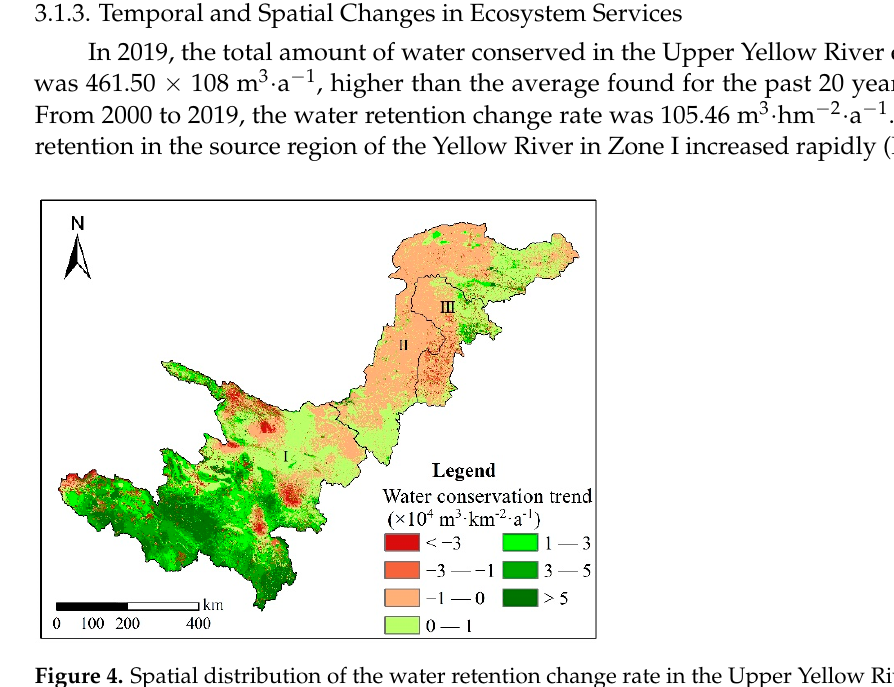
Figure 5. Spatial distributions of the soil erosion modulus ( a ) and soil conservation ( b ) change rates in the Upper Yellow River region. Figure 6. Spatial distributions of the wind erosion modulus ( a ) and windbreak and sand fixation ( b ) change rates in the Upper Yellow River region.